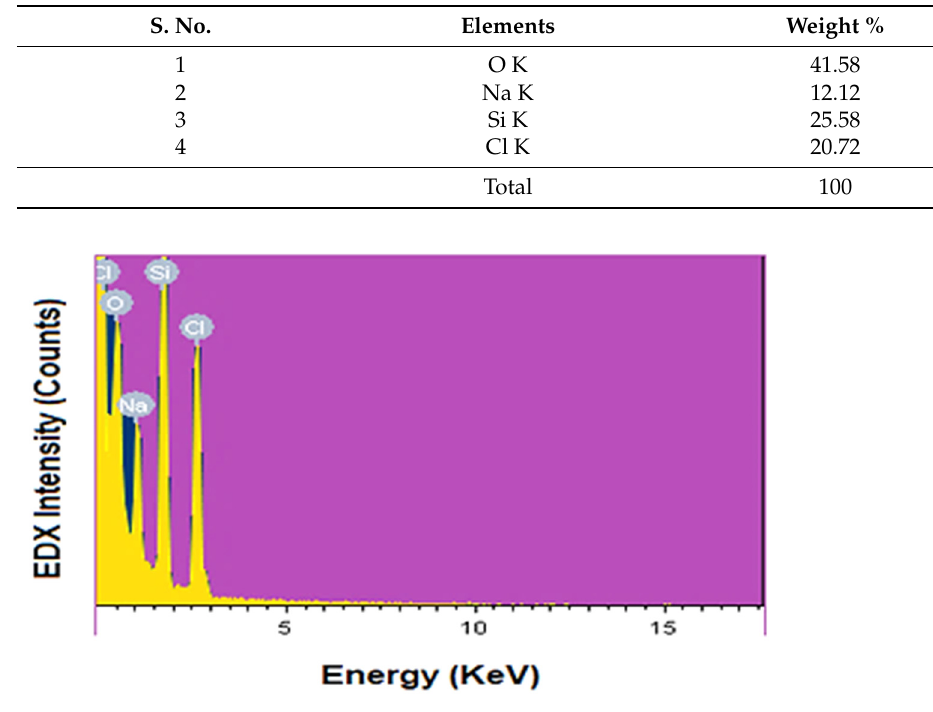
Figure 5. EDX spectra of n Si. (Purity and weight of elements were assessed.)